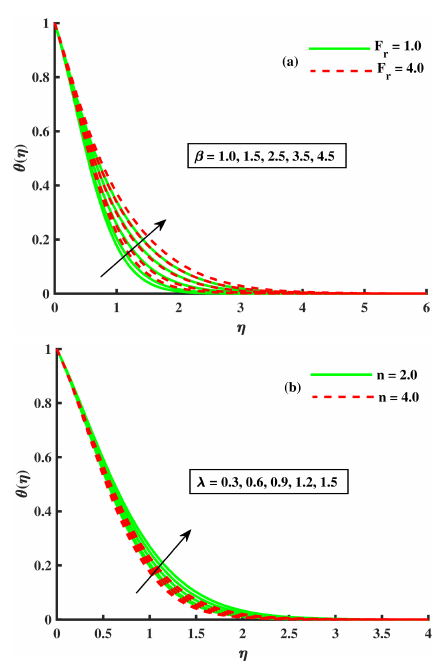
Figure 5. The effect of β , n , λ , & F r on θ ( η )